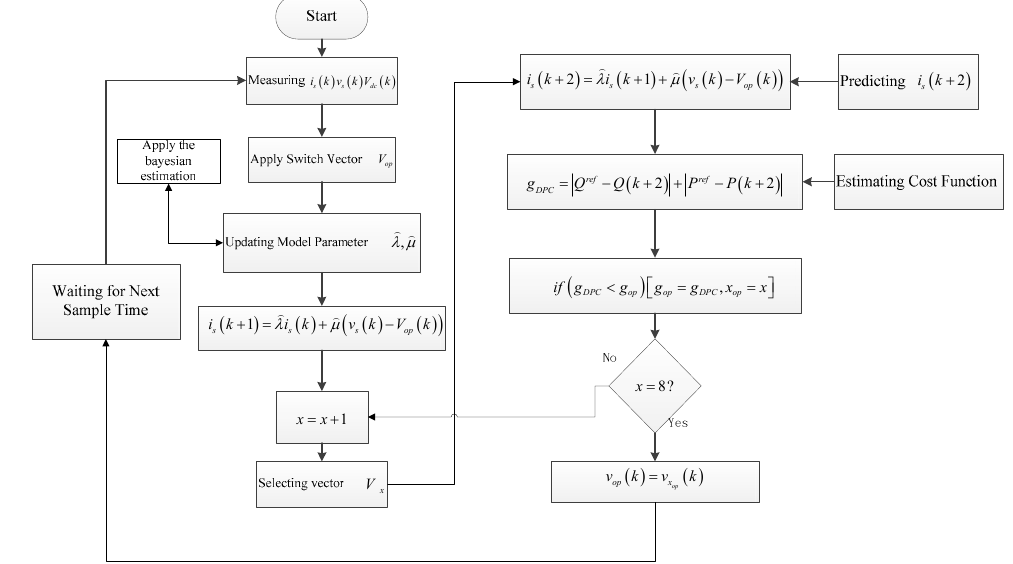
Figure 6. The flow chart of MPDPC control algorithm with Bayesian estimation.